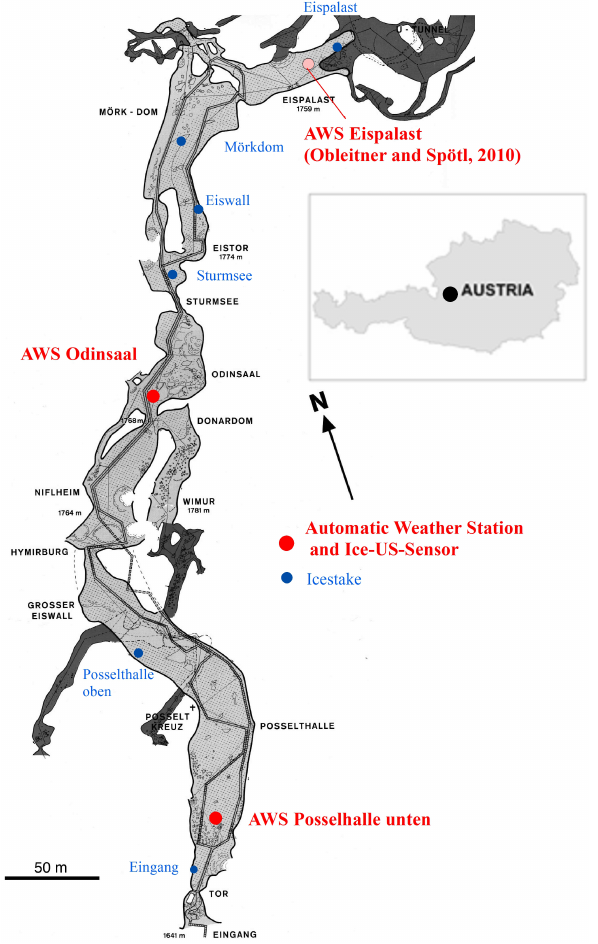
Fig. 1. Map of Eisriesenwelt and location of ice stakes (blue) and weather-stations (red) for this study. Light-grey areas marks the ice covered part of Eisriesenwelt cave, dark-grey areas marks the non- ice covered part of the cave with the overlying second entrance in the lower part of the